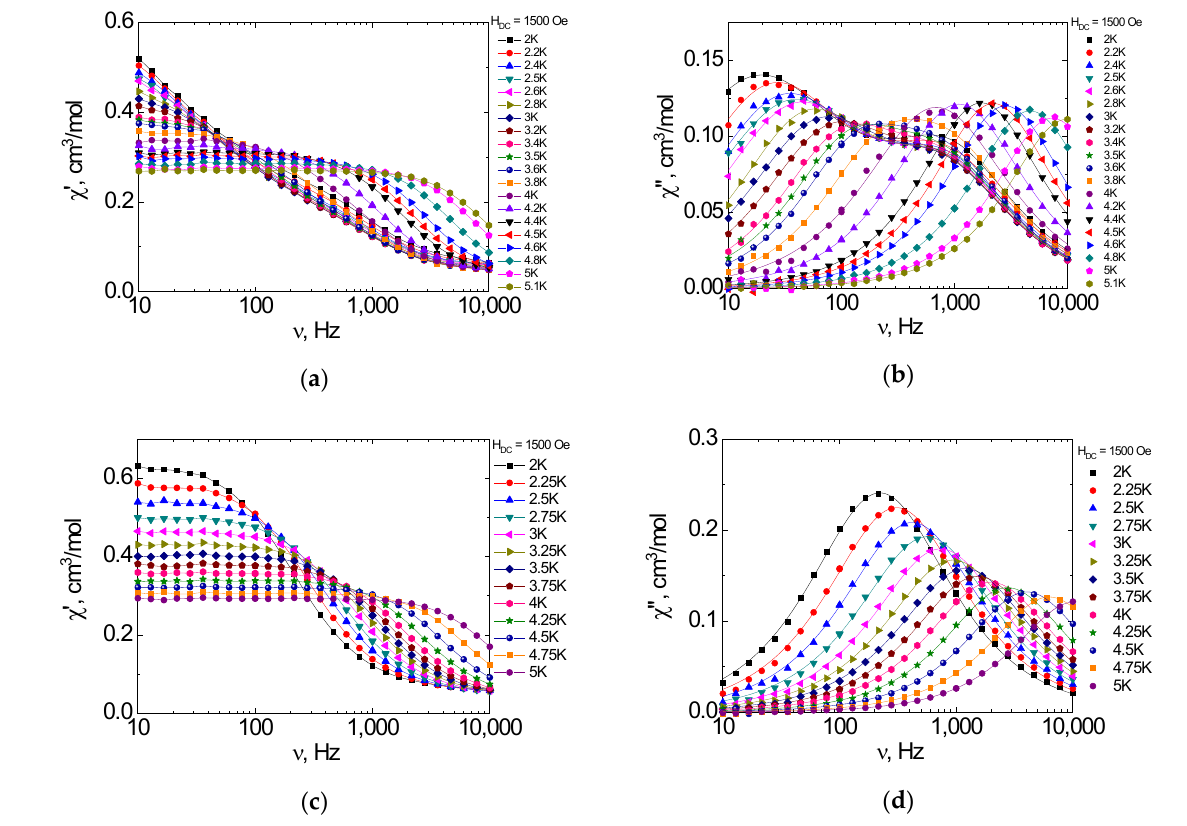
Figure 12. Frequency dependences of the in-phase χ ’ ( a , c ) and out-of-phase χ ” ( b , d ) AC susceptibility χ M at different temperatures and H DC = 1500 Oe for 1 ( a , b ) and 2 ( c , d ).